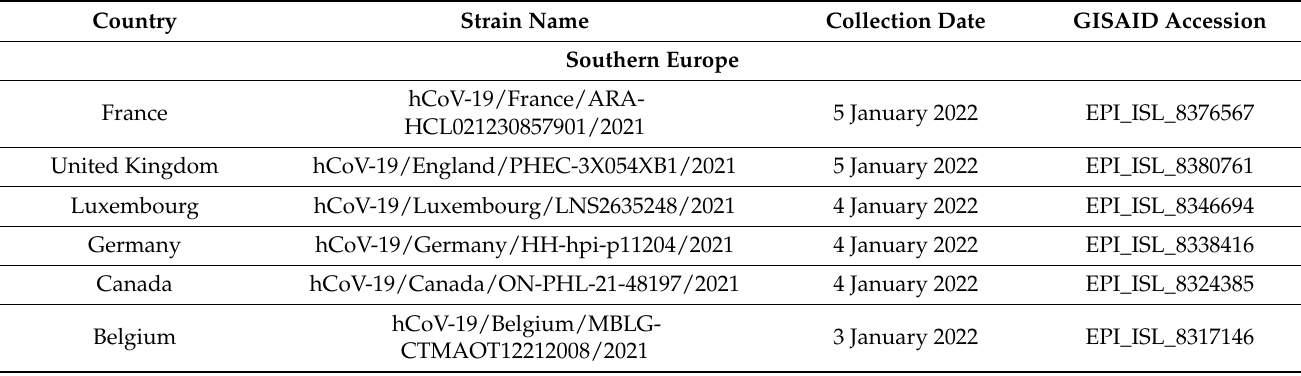
Table 8. Most recent reported occurrences in different countries according to tracking of